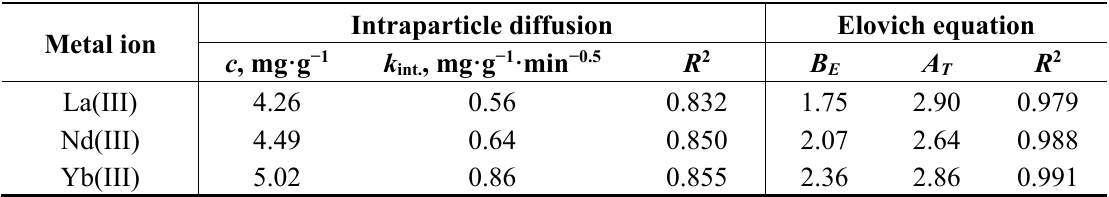
Table 2. Kinetics parameters of the Elovich and intraparticle diffusion models for the sorption of La(III), Nd(III) and Yb(III) metal ions using cysteine-based magnetic-chitosan nanoparticles ( T : 27 °C; pH: